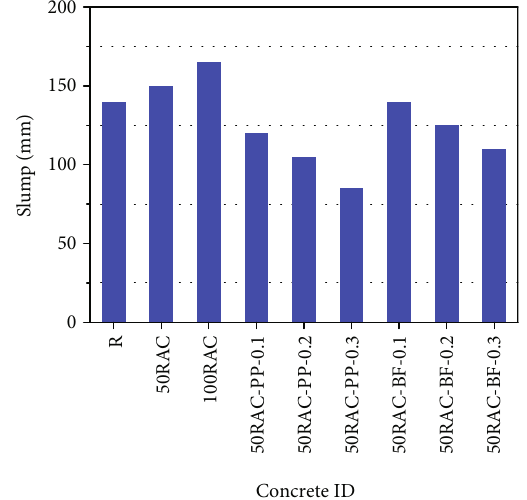
Figure 6: Slump of fresh concrete.